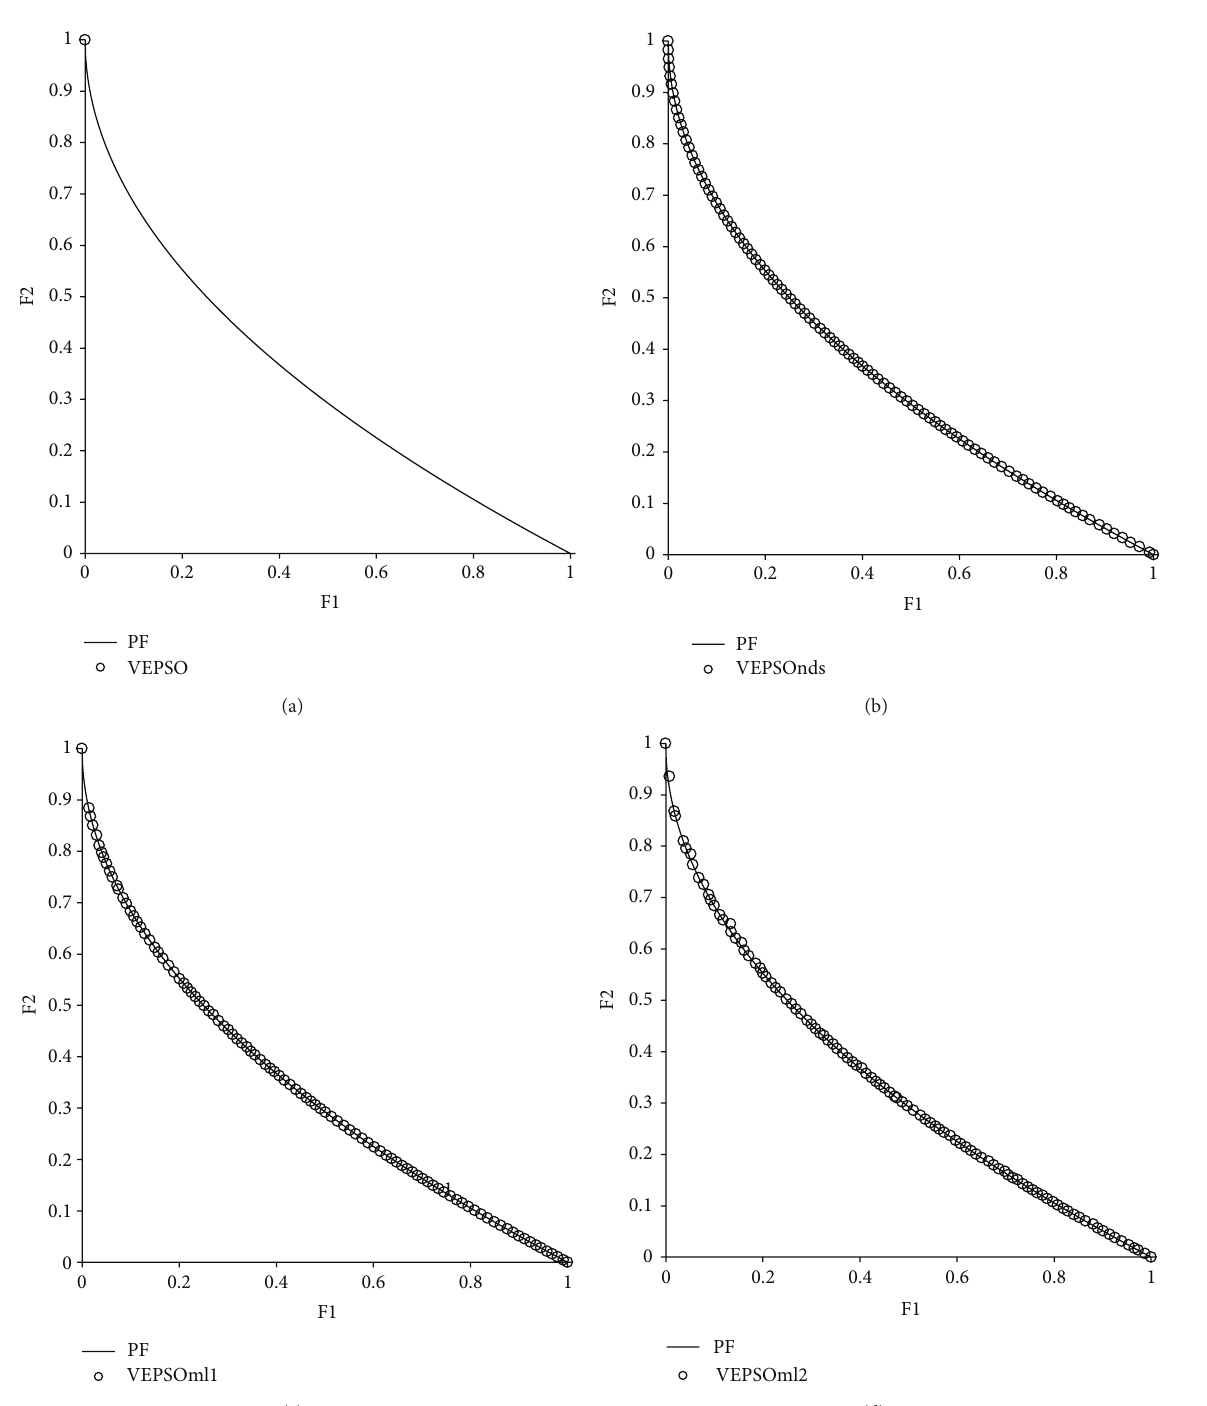
Figure 9: Plot of nondominated solutions returned by each algorithm for the ZDT4 test problem.